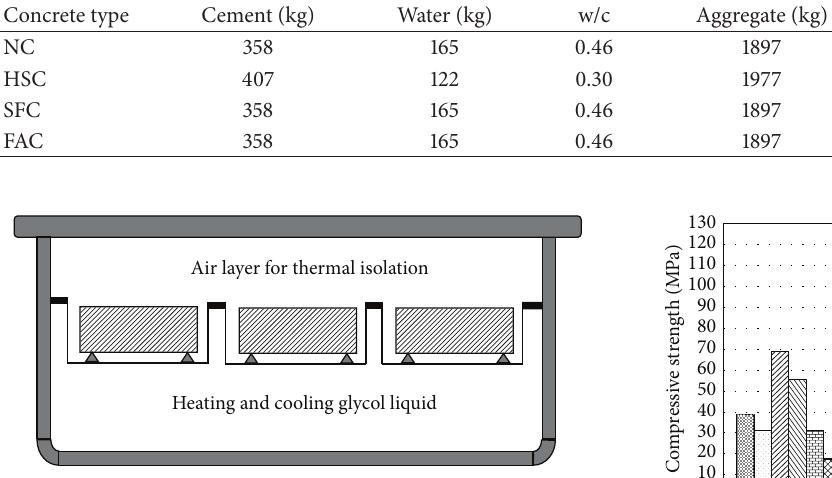
Figure 1: Temperature controlled chest.